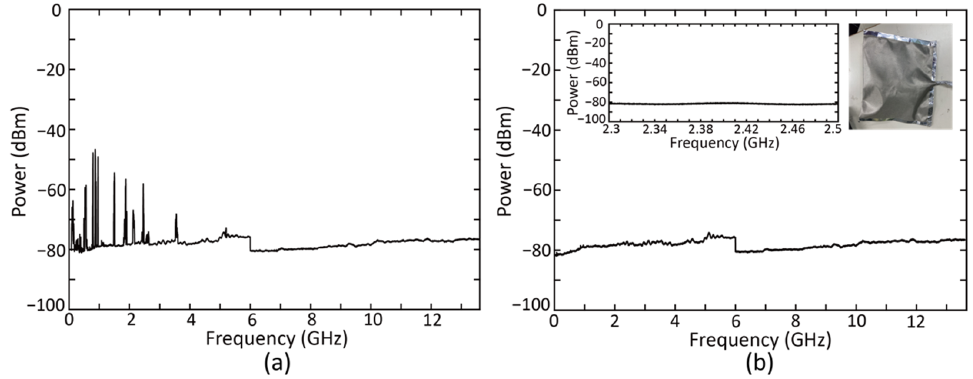
Figure 5. Electrical spectra of EC output ( a ) without and ( b ) with RF absorbing sheet. Insets of ( b ) show electrical spectrum at around center frequency of control signal and photo of RC covered with RF absorbing sheet.